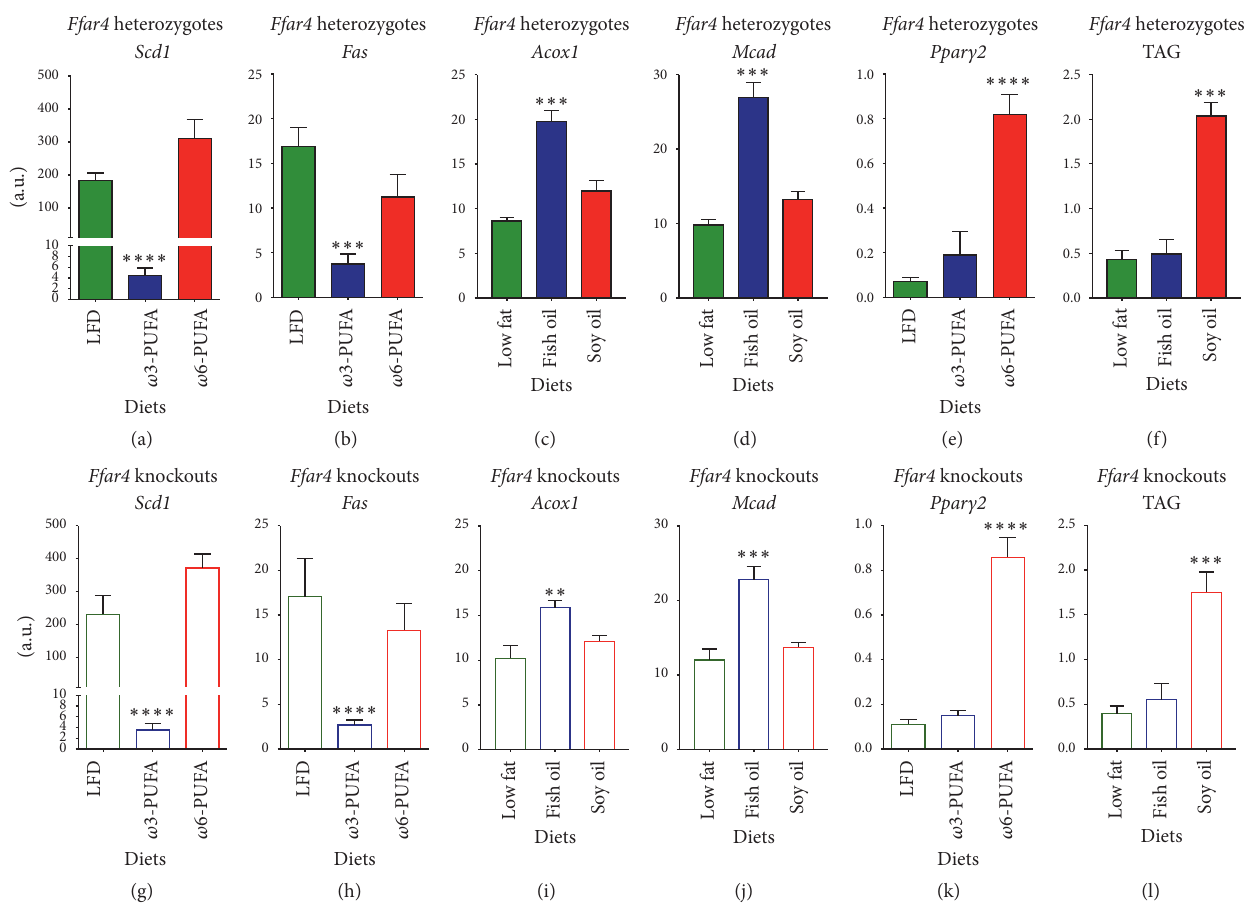
Figure 3: Intake of a high fat 𝜔 3-PUFA diet alleviates hepatic lipid accumulation in Ffar4 HET and KO mice. Mice were euthanized in nonfasting state 36 weeks after diet initiation. Gene expression levels were analyzed by RT-qPCR and lipid levels were evaluated by thin-layer chromatography. ((a)–(f)) Heterozygotes. ((g)–(l)) Knockouts. ((a) and (g)) mRNA level of Scd1 , 𝑛 = 5 –8. ((b) and (h)) mRNA level of Fas , 𝑛 = 6 –8. ((c) and (i)) mRNA level of Acox1 𝑛 = 6 –8. ((d) and (j)) mRNA level of Mcad , 𝑛 = 6 –8. ((e) and (k)) mRNA level of Ppar 𝛾 2 , 𝑛 = 6 –8. ((f) and (l)) Triacylglycerol content, 𝑛 = 6 –8. Data are presented as means ± SEM. Both HFDs have been compared to the LFD. All data have been Ln-transformed and 1-way ANOVA with Bonferroni correction was performed. Only statistical significant differences are shown. ∗∗ 𝑝 < 0.01 , ∗∗∗ 𝑝 < 0.001 , and ∗∗∗∗ 𝑝 < 0.0001